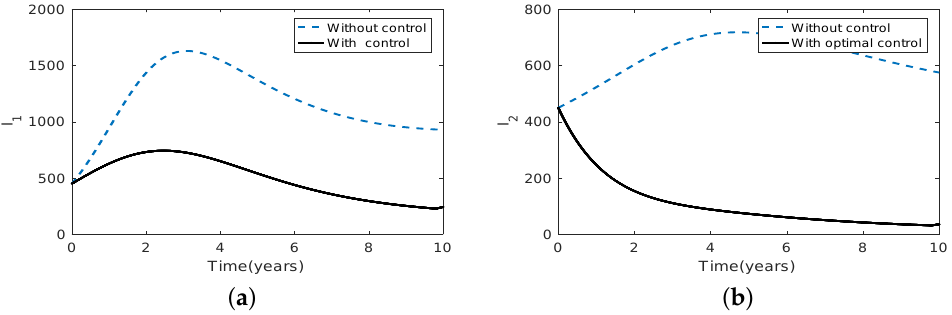
Figure 8. Numerical results highlighting the impact of optimal intervention strategies on controlling the long-term brucellosis dynamics for scenario 2 under weak asymmetric coupling ( a ) the numbers of infected animals in patch 1 ( b ) the numbers of infected animals in patch 2. In all the figures the dotted blue and solid black curves represent the infected population, without and with control,